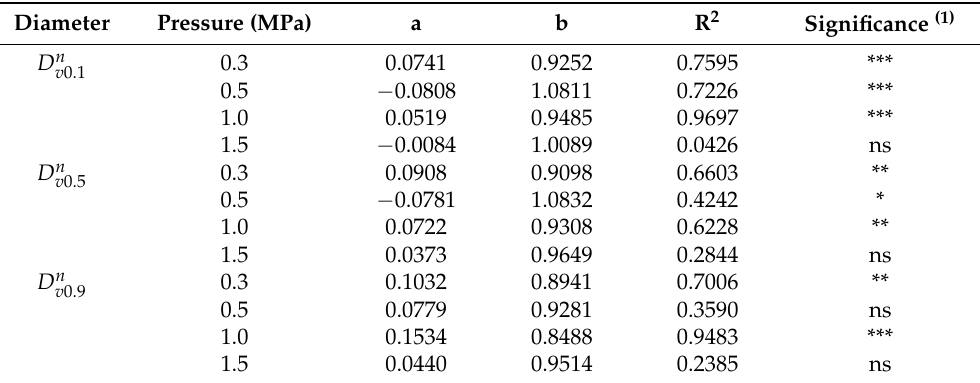
Table 2. Regression equations between normalized volumetric diameters and normalized threshold values (y = ax +